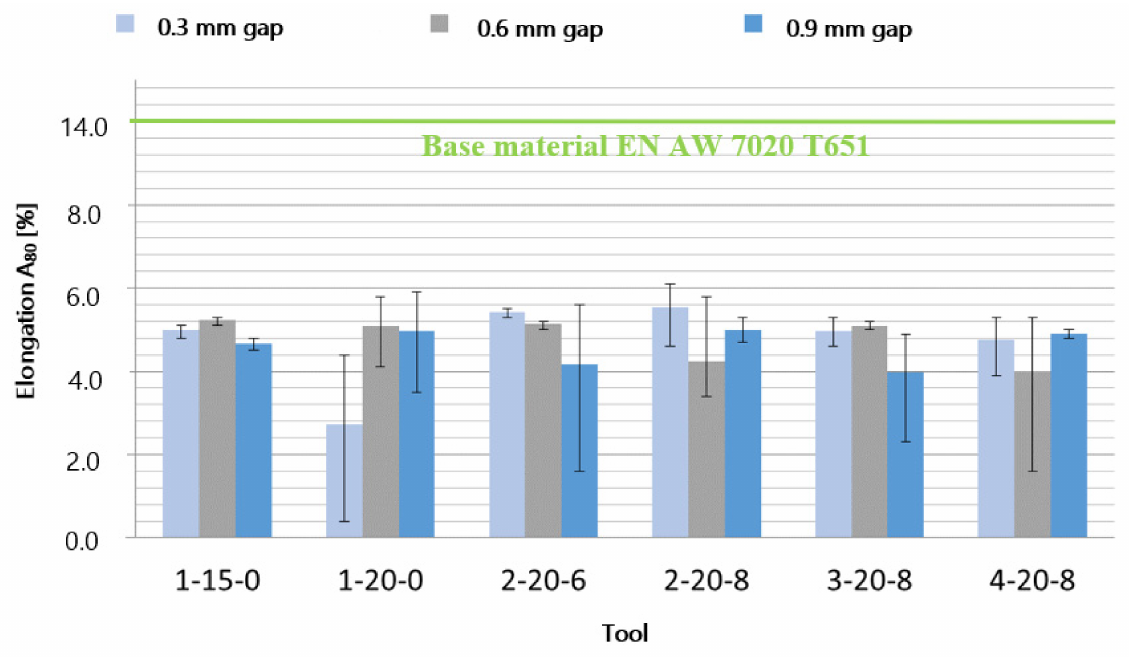
Figure 21. Comparison of the elongation at break of the welded joint on the material EN AW 7020 T651.